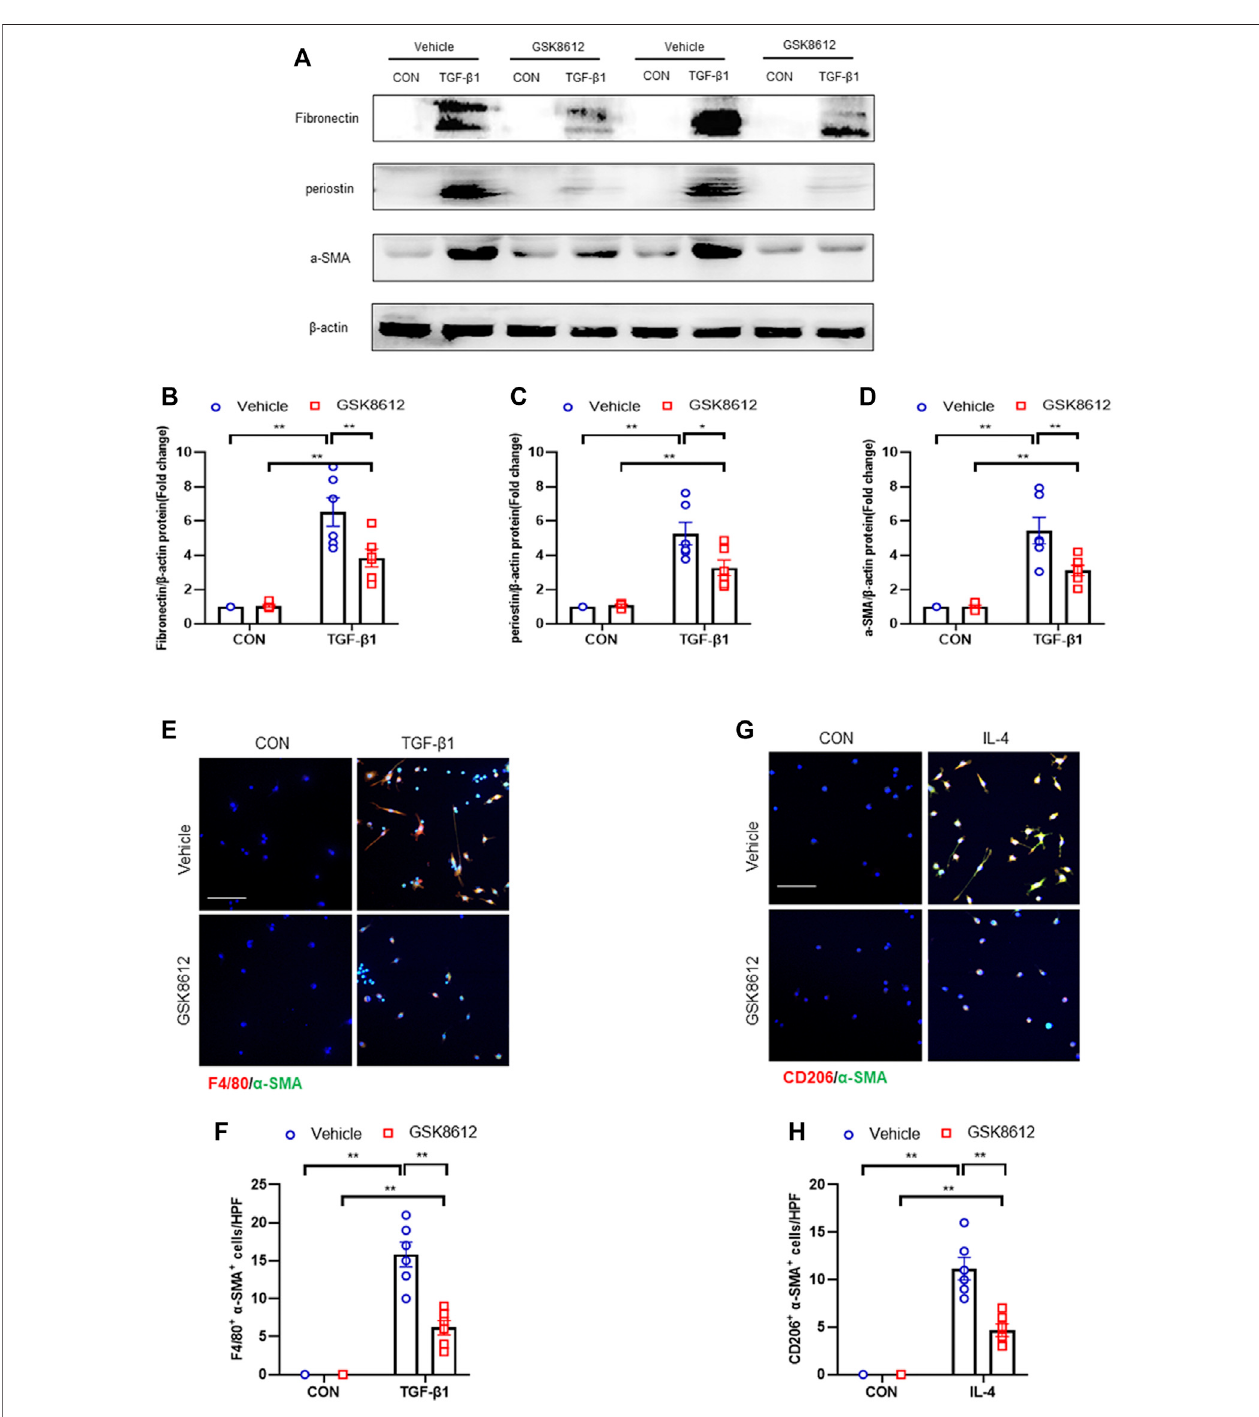
FIGURE10| GSK8612treatmentdown-regulatesECMproteinsand α -SMAexpressionandimpairsMMT invitro . (A) Representativewesternblotsshowthelevels of ECM proteins expression in cultured monocytes treated by TGF- β 1 or (and) GSK8612. (B – D) Quantitative analysis of ECM proteins expression. (E) Representative photomicrographs of cultured monocytes stained for F4/80 (red), α -SMA (green), and DAPI (blue). (F) Quantitative analysis of F4/80 and α -SMA dual positive cells. (G) Representative photomicrographs of cultured monocytes stained for CD206 (red), α -SMA (green), and DAPI (blue). (H) Quantitative analysis of CD206 and α -SMA dual positive cells. ** p < 0.01, * p < 0.05; n = 6 in each group; Scale bar: 50 μ m.